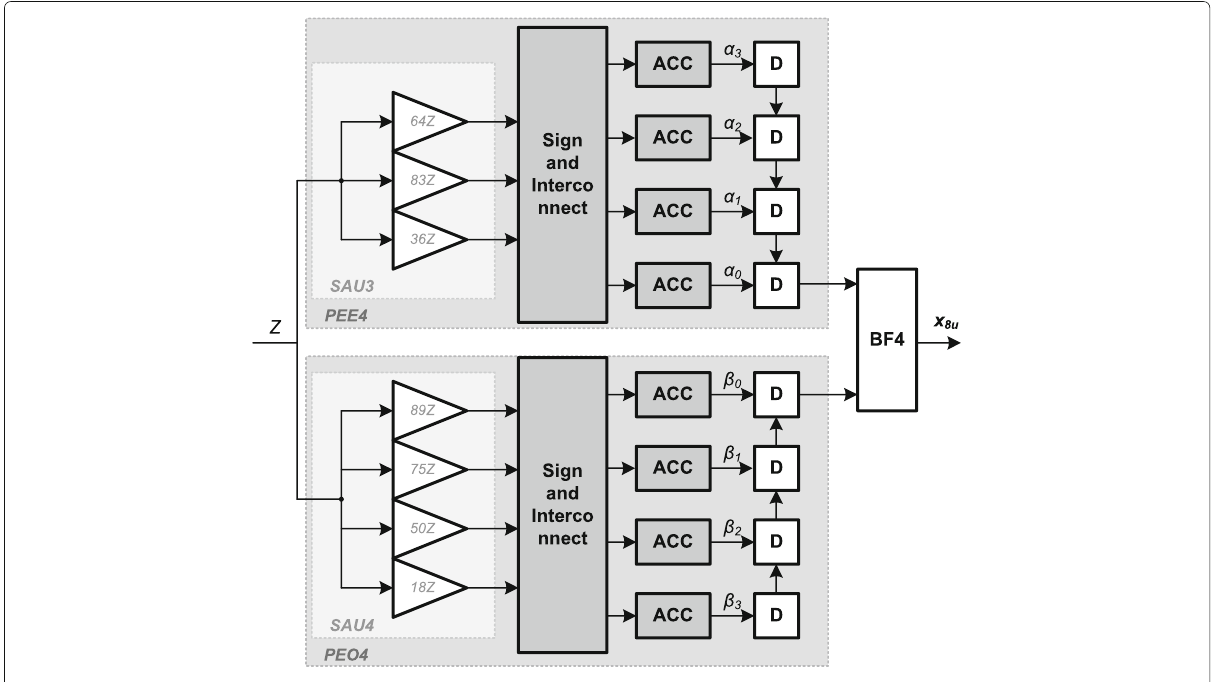
Fig. 4 Architecture of the 8-point IDCT as PEE8